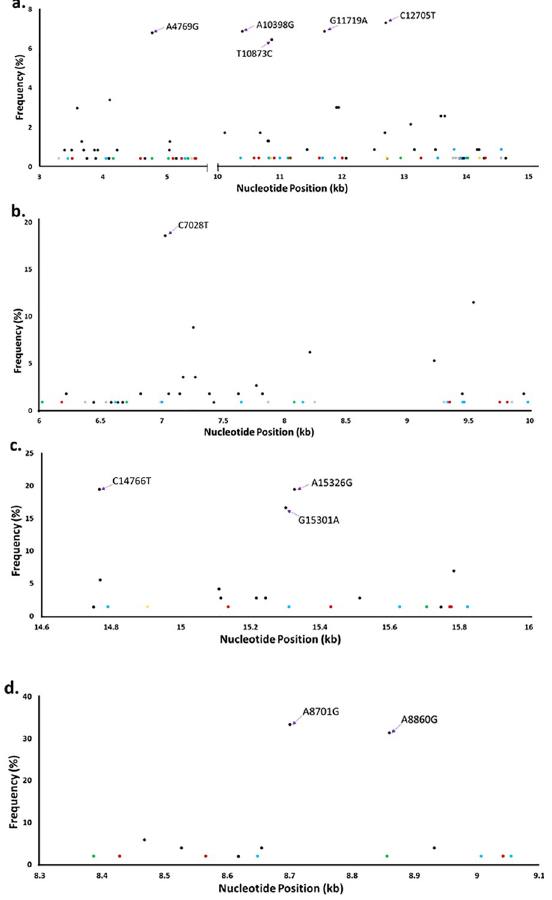
Fig 2. Point mutations at the coding region of the mtDNA of patients presenting with male infertility. The point mutations detected in only one abnormospermia are represented as oligozoospermia (brown), asthenoteratozoospermia (green), oligoasthenozoospermia (grey), oligoasthenoteratozoospermia (blue) and teratozoospermia (yellow). (a) Point mutations at genes encoding subunits of NADH dehydrogenase (ND1-ND6 genes). The brown dots are C3516A, T4586C, T5096C, G5231A, T5442C, G5460A, G10589A, C10664T, T10915C, G11176A, A11641G, G12007A, A13276G and T14308C. The green dots are A4158G, A4767G, C5027T, C5331A, T10828C, G11150A, A12948G and A14022G. The grey dots are T3308C, T5393C, T13789C, C13831A, C13880A and G14560A. The blue dots are C3450T, G4048A, A5285G, G10373A, C10837T, A11002G, C11131T, C11692T, G11887A, A13542G, A13803G, C13914A, C13992T and A14566G. The yellow dots are T10861C, A12723G and T14212C. The underlined nucleotide variants are missense mutations. A4769G, A10398G, T10873C, G11719A and C12705T (purple arrows) were the most common mutations. The total mutations at the ND1-ND6 genes = 235. (b) Point mutations at genes encoding subunits of cytochrome oxidase (CO1-CO3 genes). The brown dots are T6185C, A9347G, G9755A and C9818T. The green dots are G6026A, C6713T and C8080T. The grey dots are T6378C, C6548T, A6989G, C7867T, A8248G, G9300A and A9855G. The blue dots are T6620G, A7004G, C7648T, G8152A, G9329A, G9452A, T9467C and G9986A. The underlined nucleotide variants are missense mutations. C7028T was the most common mutations (purple arrows). The total mutations at the CO1-CO3 genes = 113. (c) Point mutations at genes encoding cytochrome B (CYTB). The brown dots are C15136T, G15431A, G15773A and G15777A. The green dot is A15707G. The blue dots are C14791T, A15311G, T15629C and A15824G. The yellow dot is G14905A. The underlined nucleotide variants are missense mutations. C14766T, G15301A and A15326G (purple arrows) were the most common mutations. The total mutations at the CYTB gene = 72. (d) Point mutations at genes encoding subunits of ATPase (ATPase6/8). The brown dots are C8428T, A8566G and C9042T. The green dots are G8387A and G8856A. The blue dots are A8649G, A9007T and G9055A. The underlined nucleotide variants are missense mutations. A8701G and A8860G (purple arrows) were the most common mutations. The total mutations at the ATPase6/8 genes =